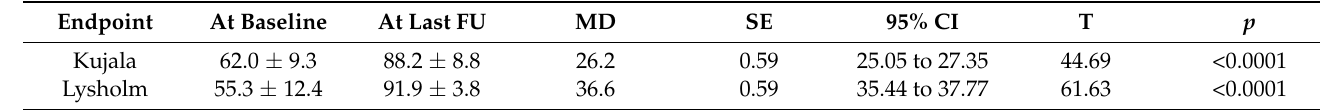
Table 2. Results of PROMs (FU: follow-up; MD: mean difference; SE: standard error; CI: confi- dence